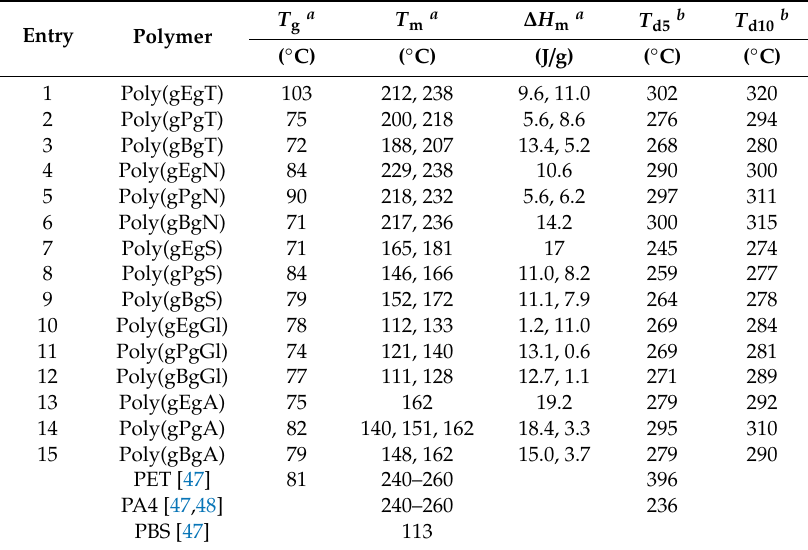
Table 2. Thermal properties of the sequential poly(ester